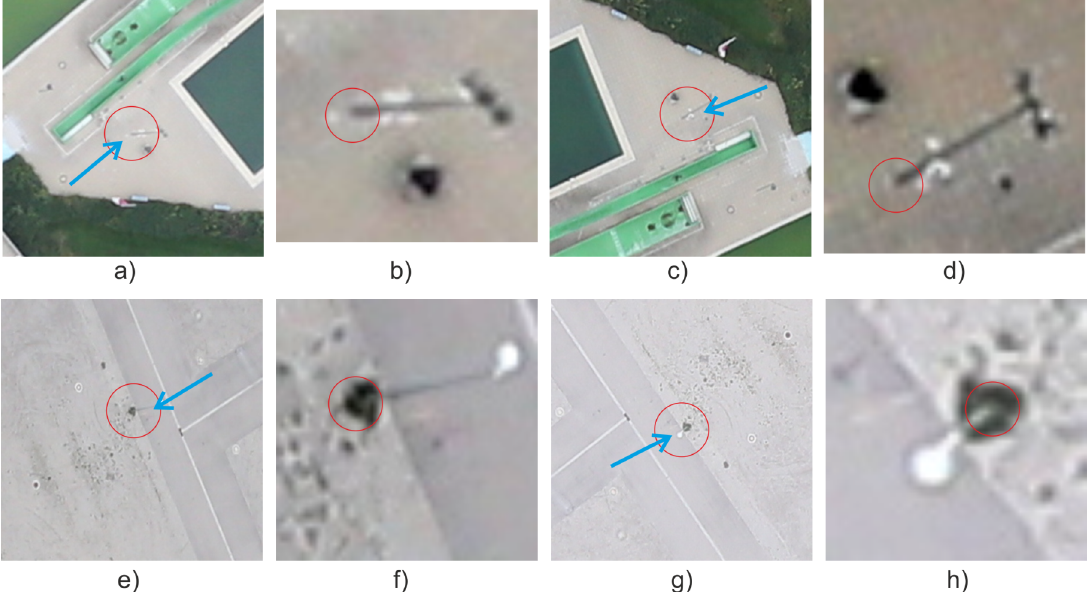
Figure 6. Aerial image samples of SAR-GCPs derived from SAR scenes in one looking direction (blue arrows): a) , b) , e) and f) poles observed from aerial images in the same looking direction like the SAR satellite; c) , d) , g) and h) poles observed from aerial images in the opposite looking direction like the SAR